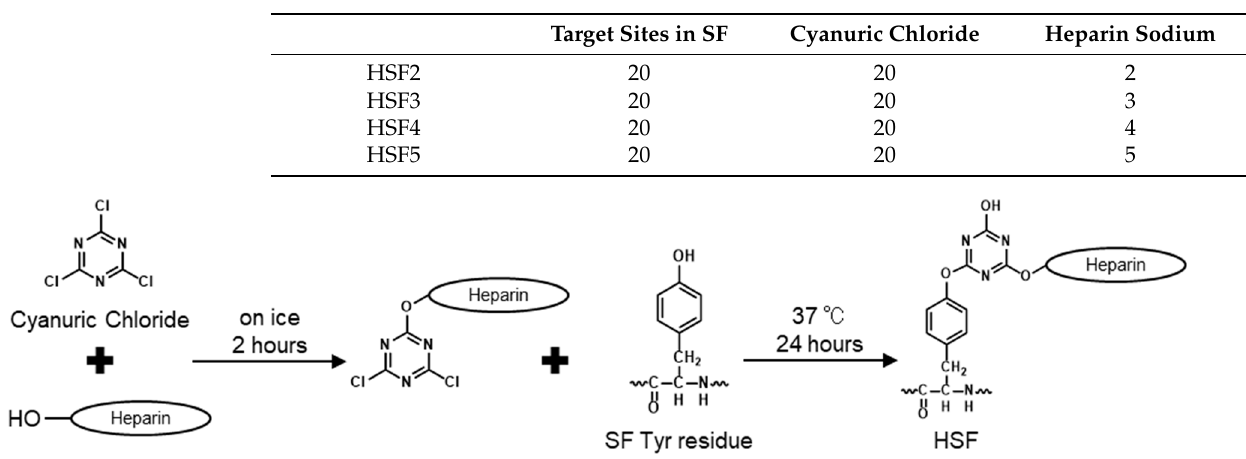
Table 1. Reaction points in SF and the molar ratio of each reagent used for the reaction.